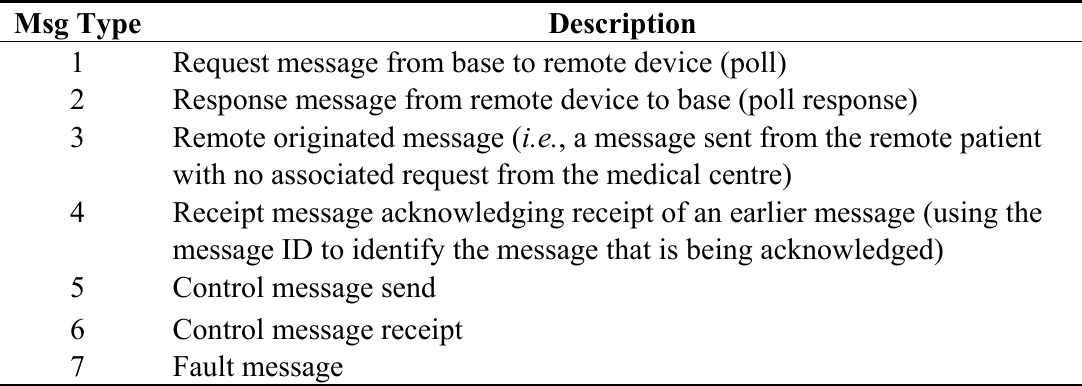
Table 2. Allowable values of the message type